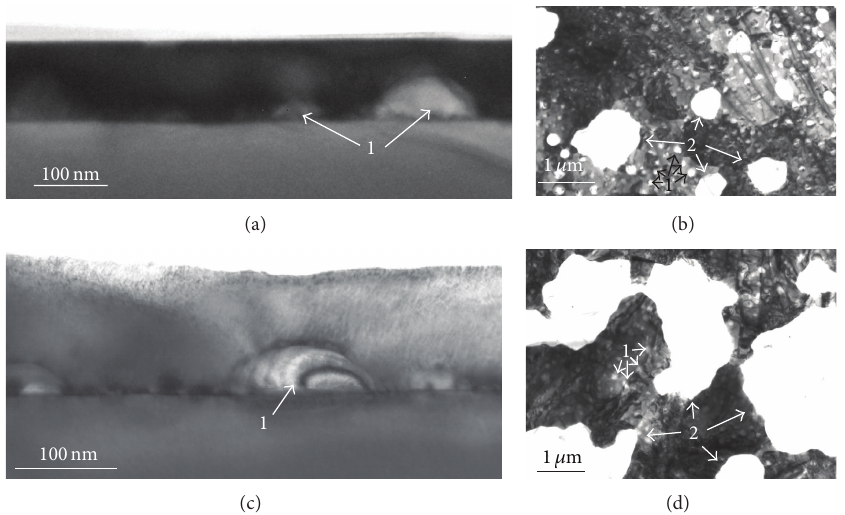
Figure 8: Cross-sectional (a, c) and plan-view (b, d) TEM micrographs obtained from Ni/Si/Ni/Si/4H-SiC contact annealed at 600 ∘ C and subsequently at 1050 ∘ C (a, b) or 1100 ∘ C (c, d). Exemplary voids are indicated with number 1 and discontinuities of the layer are indicated with number